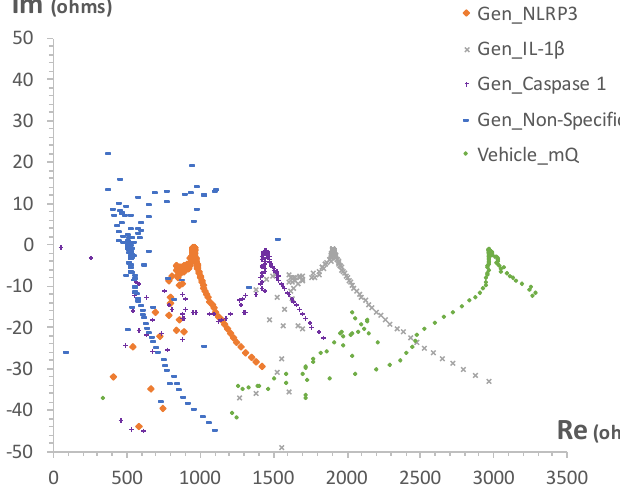
Fig. 3. Nyquiste plot EBiS spectra for the three genes studied (NLRP3, IL-1B and Caspase 1) as well as control (vehicle) and negative control (non-specific gene) conditions.